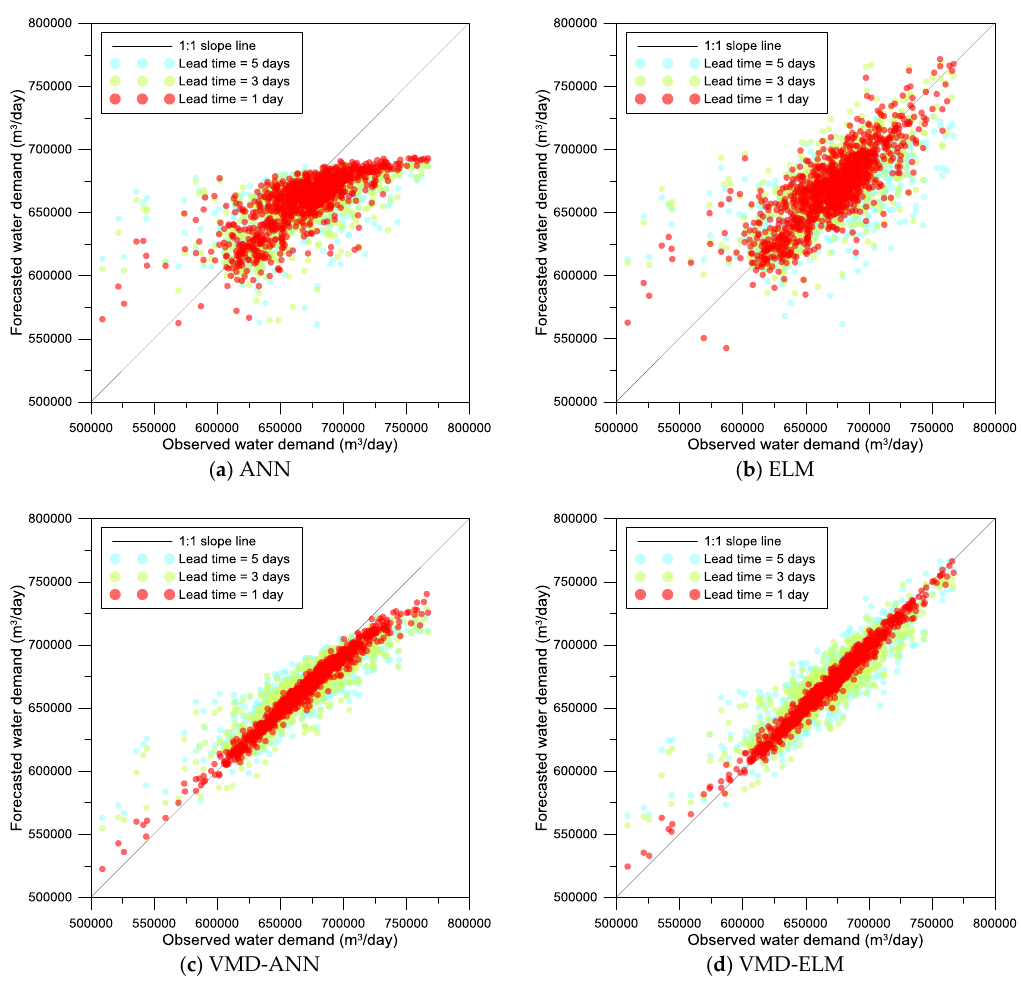
Figure 8. Scatter diagrams for single and VMD-based forecasting models.